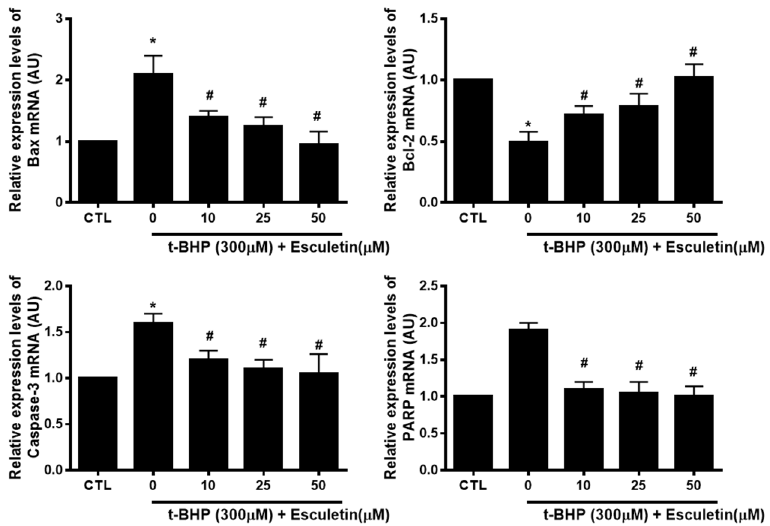
Figure 4. Effect of esculetin on apoptosis-related signaling pathways in HEK293 cells. ( A ) Apoptosis-related protein assay. ( B ) In the bar graphs, the values represent means ± SD, n = 5. * p < 0.05 vs. untreated control group, # p < 0.05 vs. t-BHP-treated group.